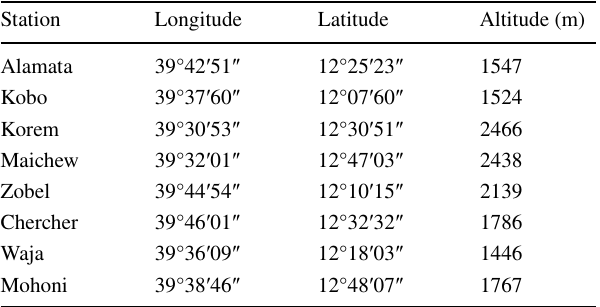
Table 1 Geographic coordinates and altitude of meteorological sta- tions